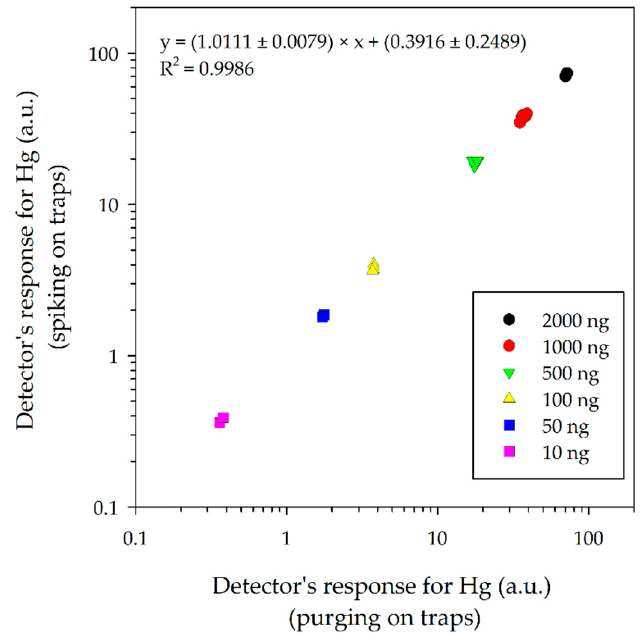
Figure 1. Linear dependence of the detector’s signal for Hg on activated carbon traps (AIC-500) obtained by two loading methods (purging onto carbon traps and spiking on activated carbon). a.u.—arbitrary units.